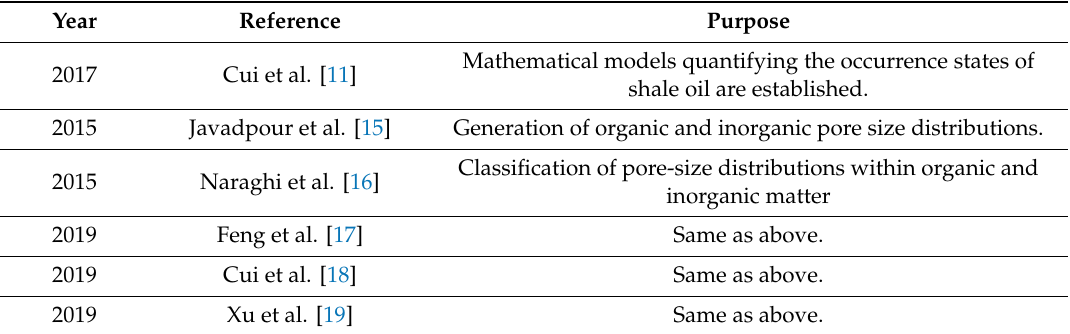
Table 1. Gaussian Mixture Model—literature